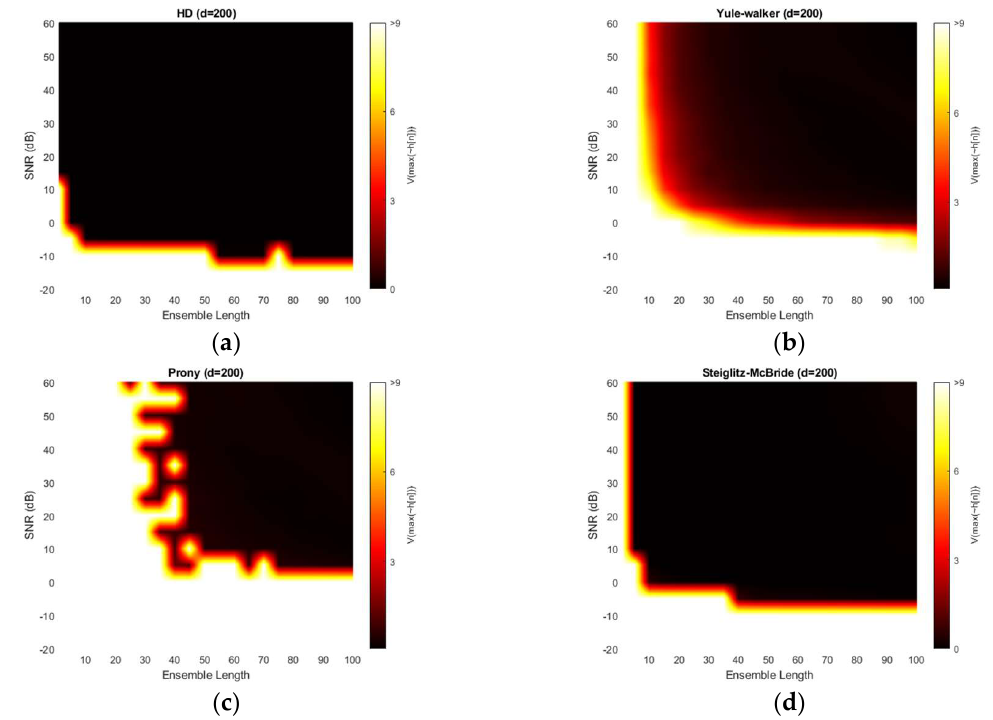
Figure 16. Variance of estimation with given ensemble average length & SNR for 200-sample delay: ( a ) non-parametric HD; ( b ) Yule-walker HD; ( c ) Prony HD; ( d ) Steiglitz-McBride HD.